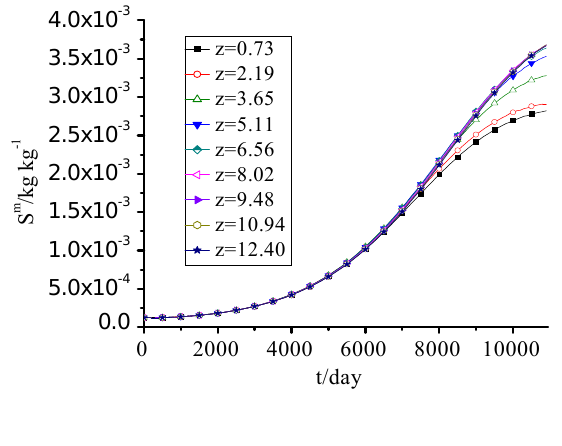
Figure 8. MS concentration change with